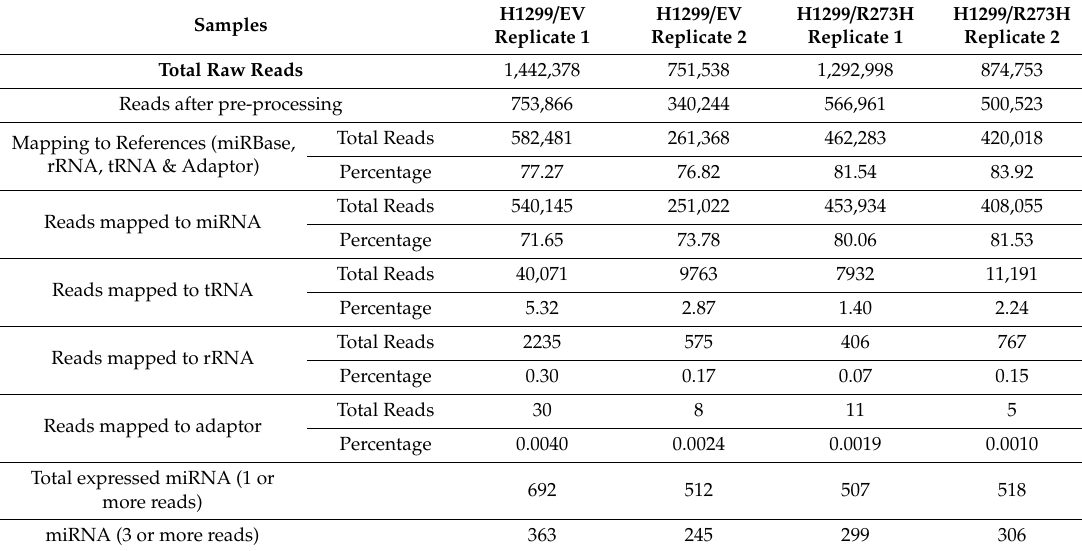
Table 1. Sequencing summary of the small RNA libraries. Raw reads were quality processed and aligned to the reference human genome (GRCh37 / hg19) and miRBase (miRBase20). Total number and the percentage of processed reads mapped to miRNA, tRNA, rRNA, and adaptors are shown. The number of miRNAs identified in each sample with ≥ 1 or ≥ 3 read counts are